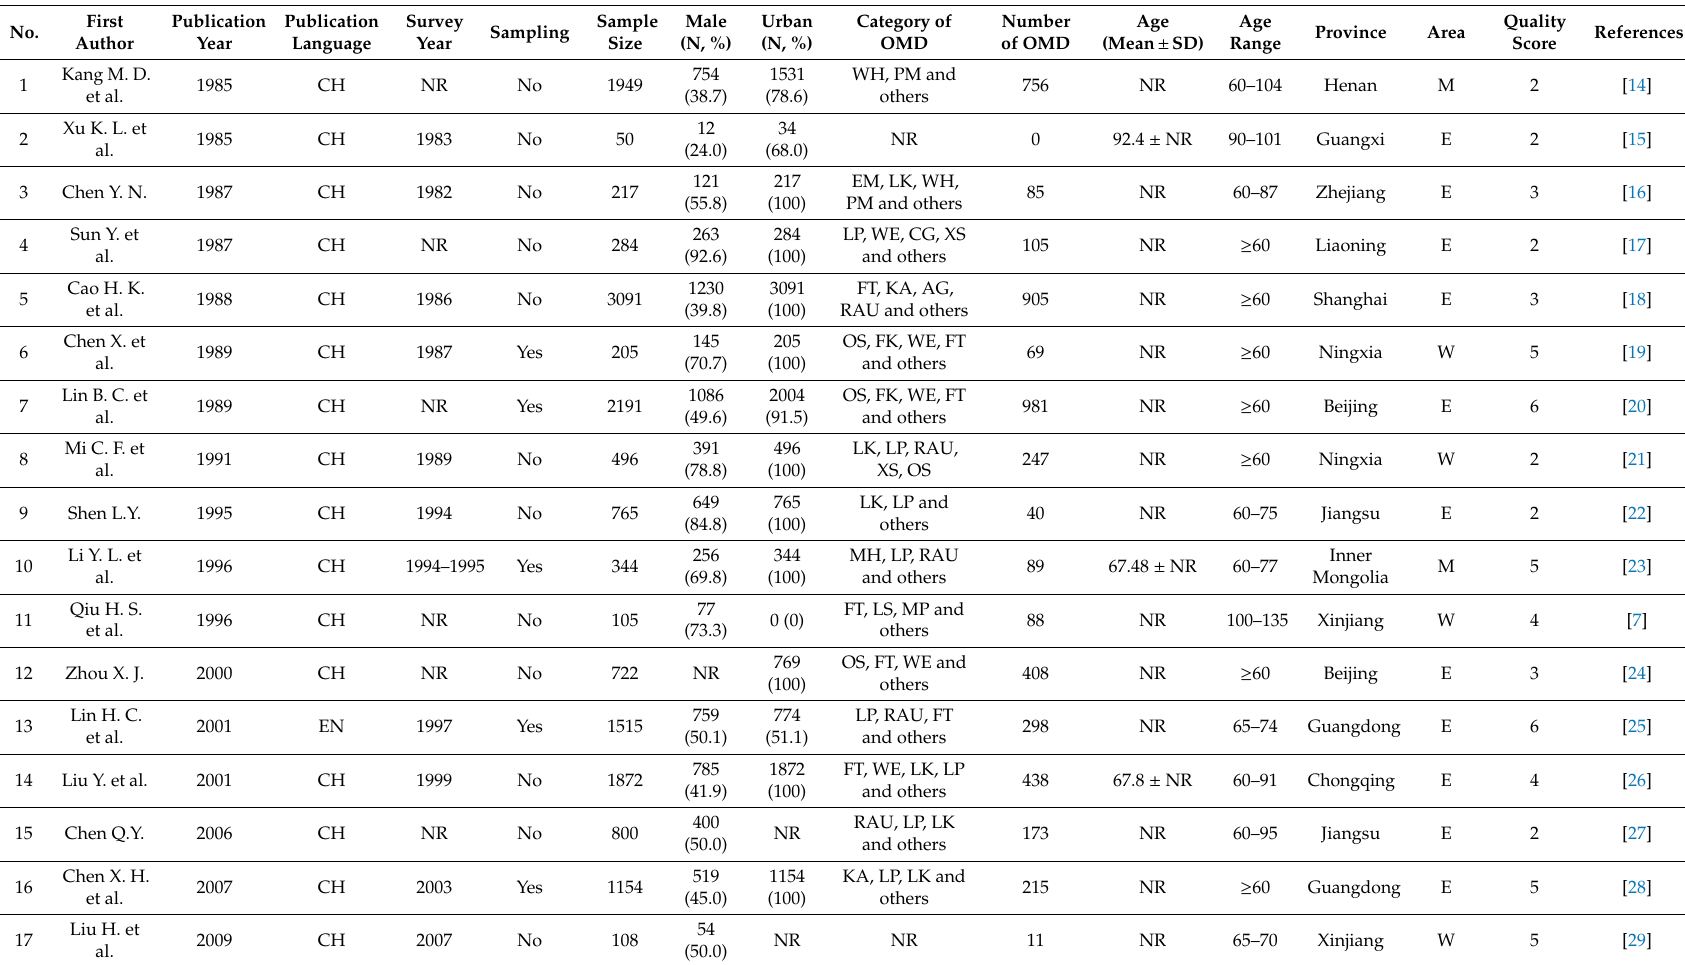
Table 1. Characteristics of the studies included in the